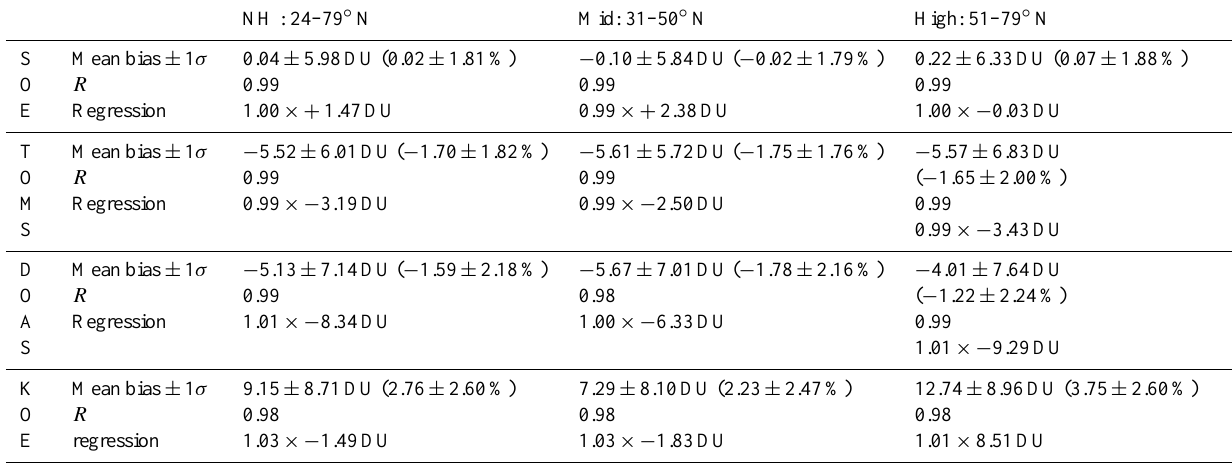
Table 3. Comparison statistics* between OMI and Brewer total column ozone data for the Northern Hemisphere (NH), mid-latitudes, and high